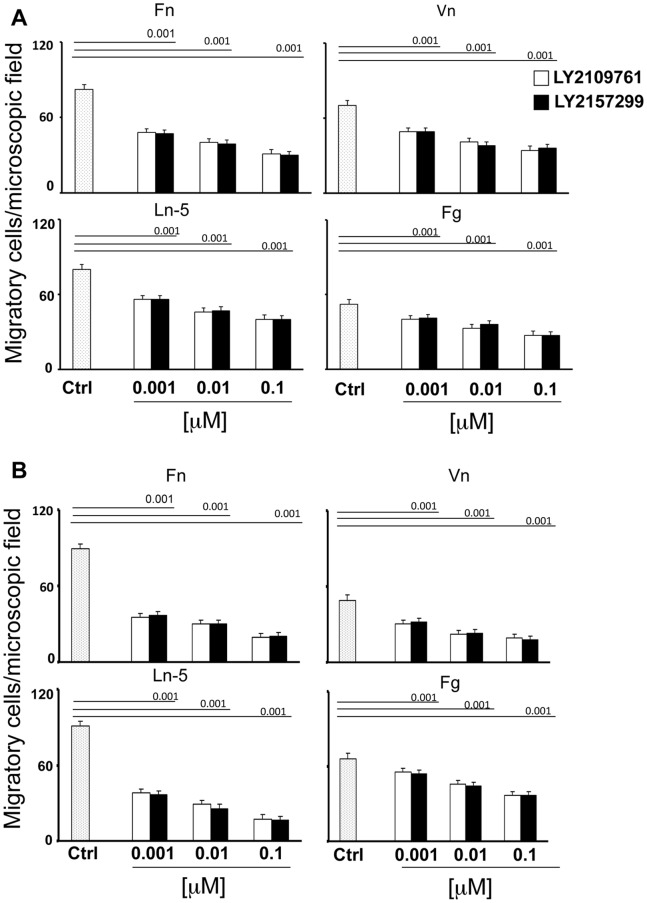
Comparison of the effect of two TGF-βR inhibitor analogs, LY2109761 and LY2157299, on HCC cell migration on different extracellular matrix components.(A) HLE and (B) HLF cells were allowed to migrate for 16 hours on fibronectin (Fn), vitronectin (Vn), laminin-5 (Ln-5) and fibrinogen (Fg) in the presence or absence (vehicle) of increasing concentrations of LY2109761 or LY2157299. All conditions were performed in duplicate, and each experiment was repeated at least three times. Results of representative experiments are shown, and values are expressed as mean ± standard deviation.